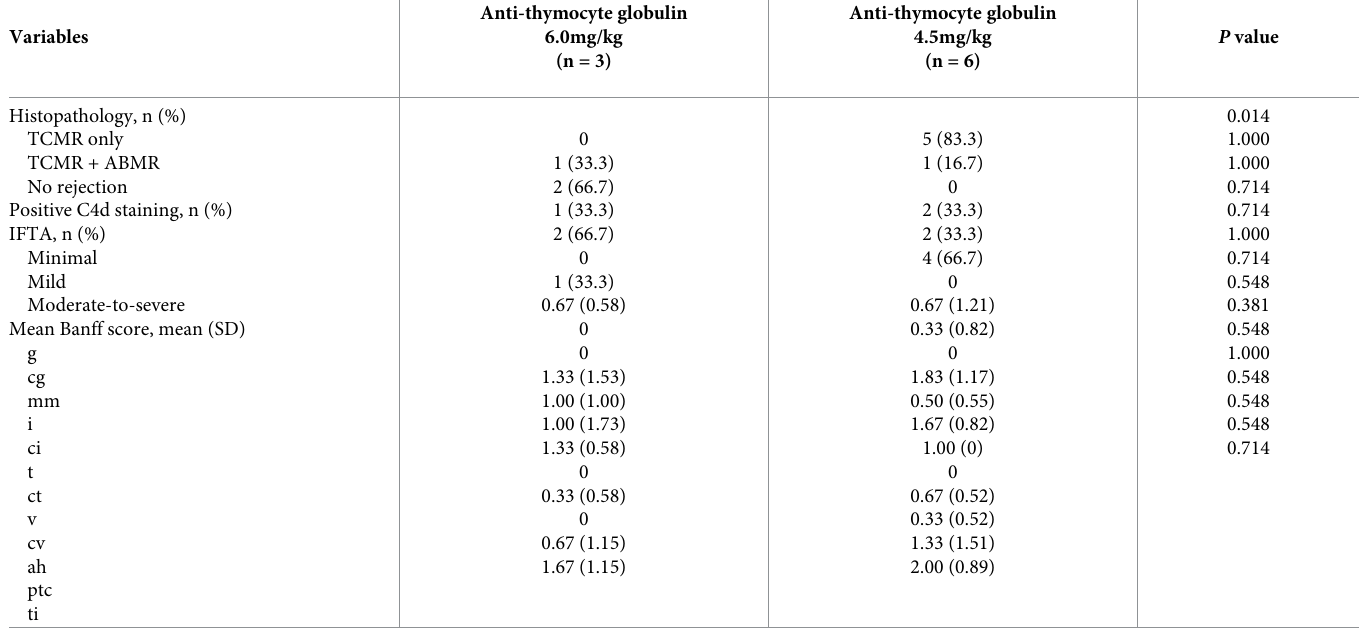
During the follow-up period, six patients in the ATG4.5 group and three patients in the ATG6.0 group underwent a for-cause biopsy (Table 3). Among the six patients in the ATG4.5 group, five patients had TCMR only and one patient had both TCMR and ABMR. Among the three patients in the ATG6.0 group, only one patient had pathologic features compatible with acute rejection. There were no significant differences between the two groups in terms of posi- tive C4d staining, interstitial fibrosis and tubular atrophy, and Banff scores. Comparison of reconstitution of peripheral lymphocytes and monocytes At pre-transplantation, the two groups did not show significant differences in the proportions of lymphocytes and monocytes among PBMCs and the proportions of T, B, NK, and NKT Table 3. Comparison of histopathologic characteristics according to the dosage of anti-thymocyte globulin.